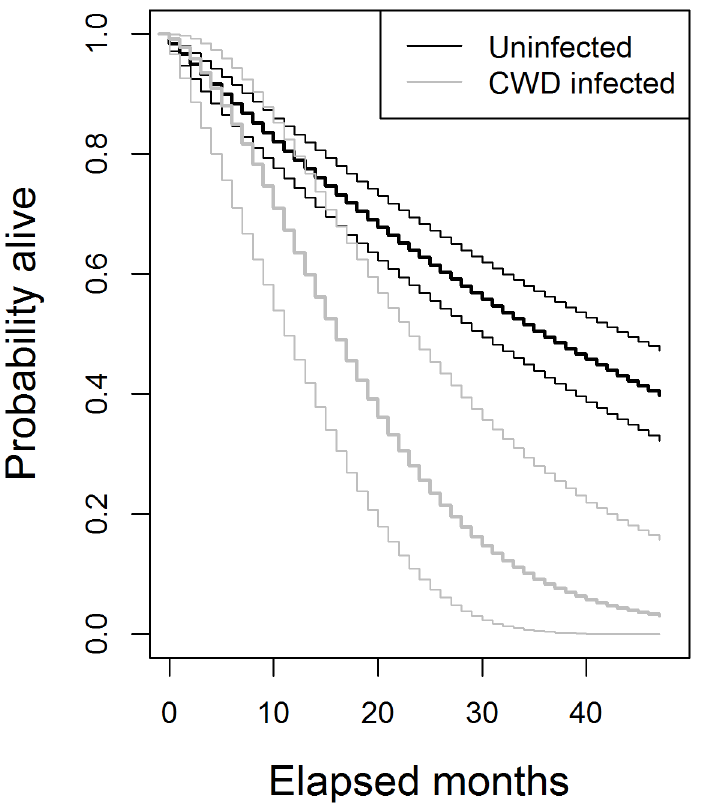
Fig 4. Deer survival after testing positive for CWD. Median (bold) and 95% credible intervals of probabilities of surviving the given number of additional months.